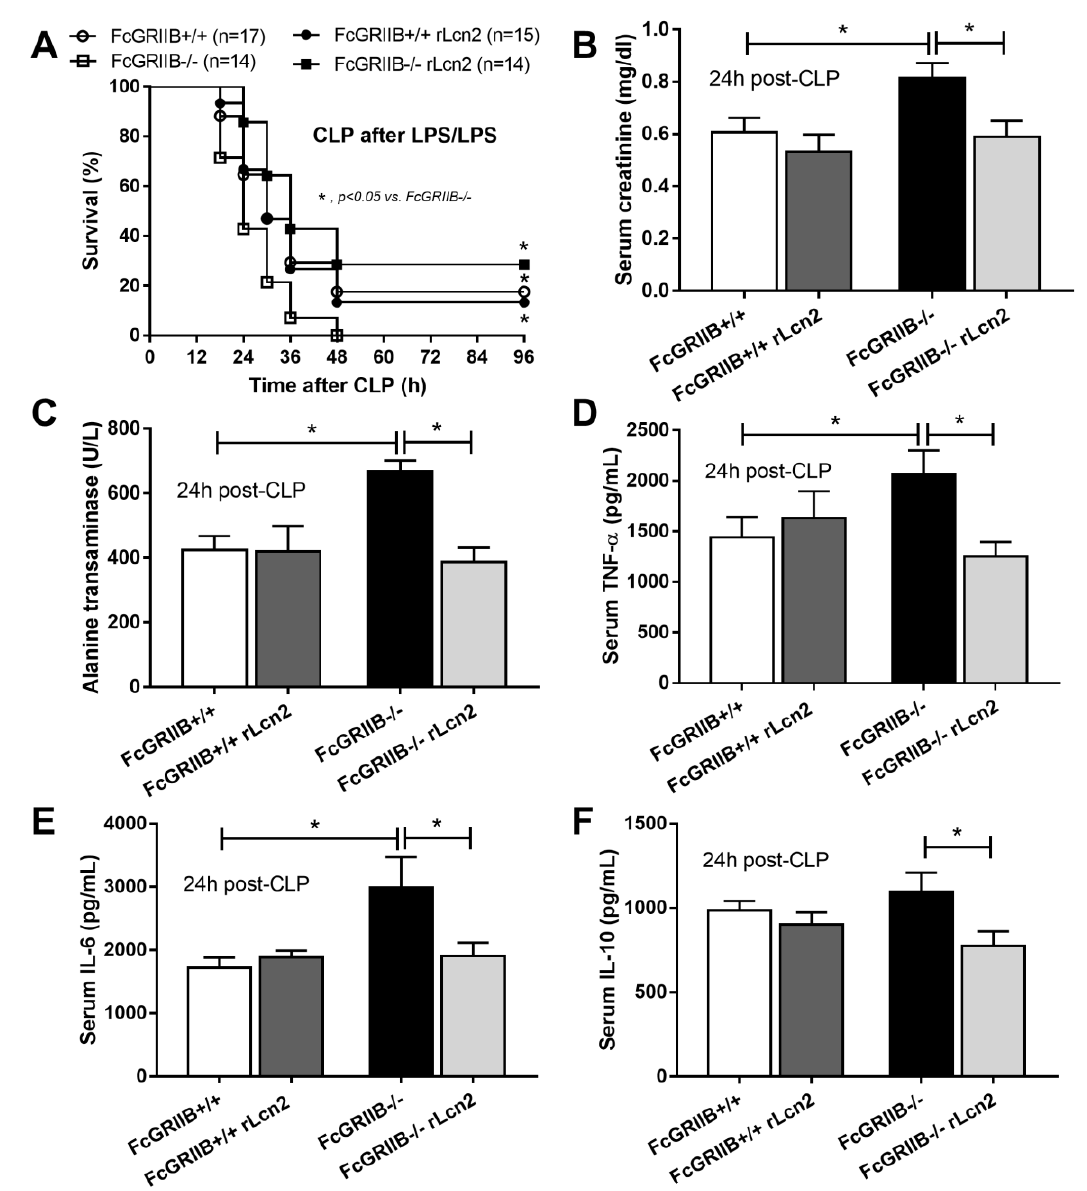
Figure 9. The characteristics of cecal ligation and puncture sepsis surgery after LPS tolerance induction by sequential LPS stimulation (CLP after LPS/LPS) (see method) in wild-type (WT) and FcGRIIb-/- mice with and without recombinant Lcn-2 (rLcn-2) administration as evaluated by survival analysis ( A ) and serum markers of injury including serum creatinine ( B ), alanine transaminase ( C ) and cytokines ( D – F ) ( n = 7–10/group for B–F) were demonstrated. *, p < 0.05.